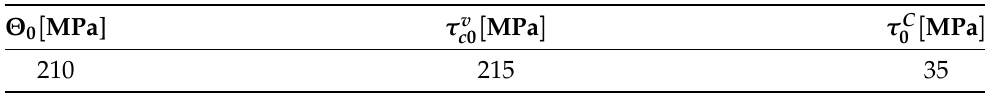
Table 3. Found out parameters using the Taylor model and the trial-and-error method (inverse